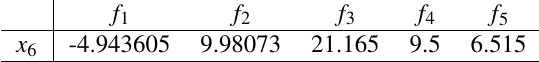
Table 2. Attribute values of the signal x